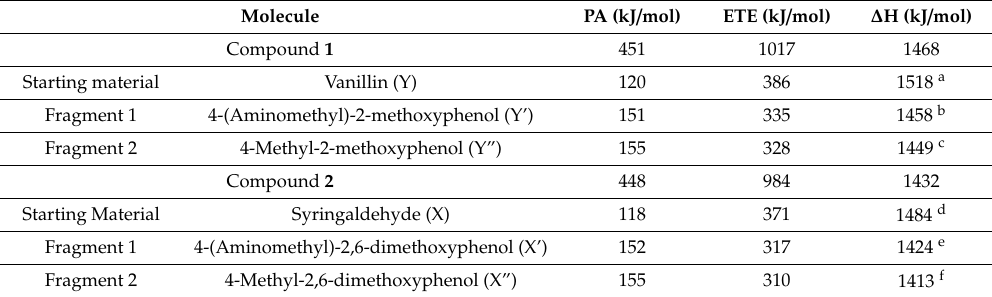
Table 5. PA, ETE and ∆ H of starting materials and fragments of compounds 1 and 2 . Molecule PA (kJ /